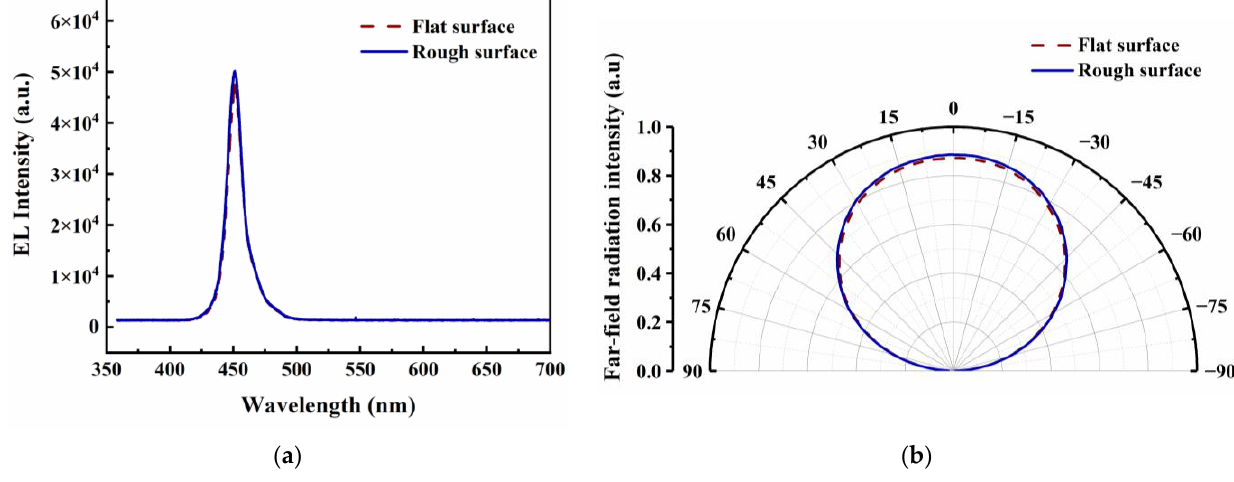
Figure 6. ( a ) EL spectra and ( b ) measured far-field radiation intensity of Si 3 N 4 -passivated LEDs with a flat surface and with a rough surface at 350 mA.